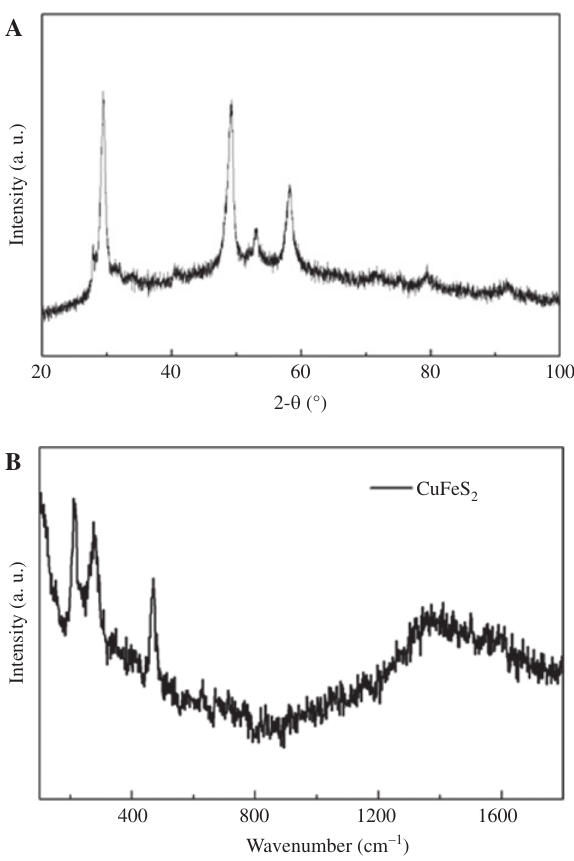
Figure 3: XRD (A) and Raman spectra (B) of the the CuFeS nanoparticles.